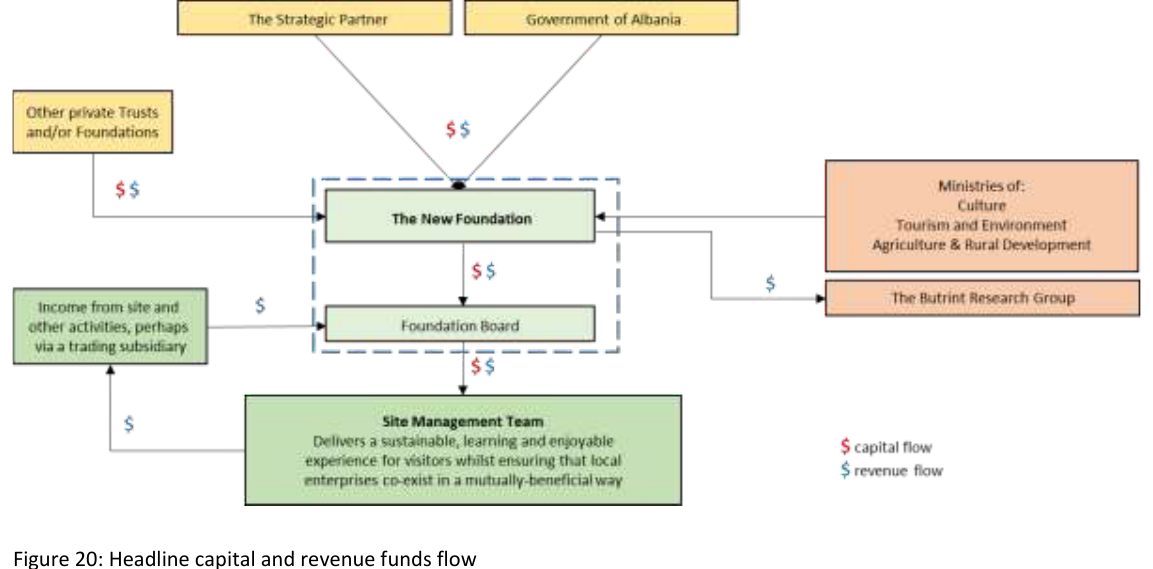
Figure 20: Headline capital and revenue funds